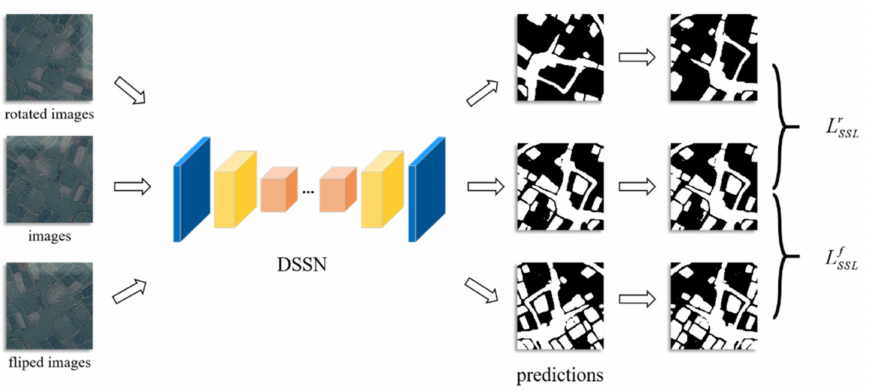
Figure 3. The structure of geometric transformation